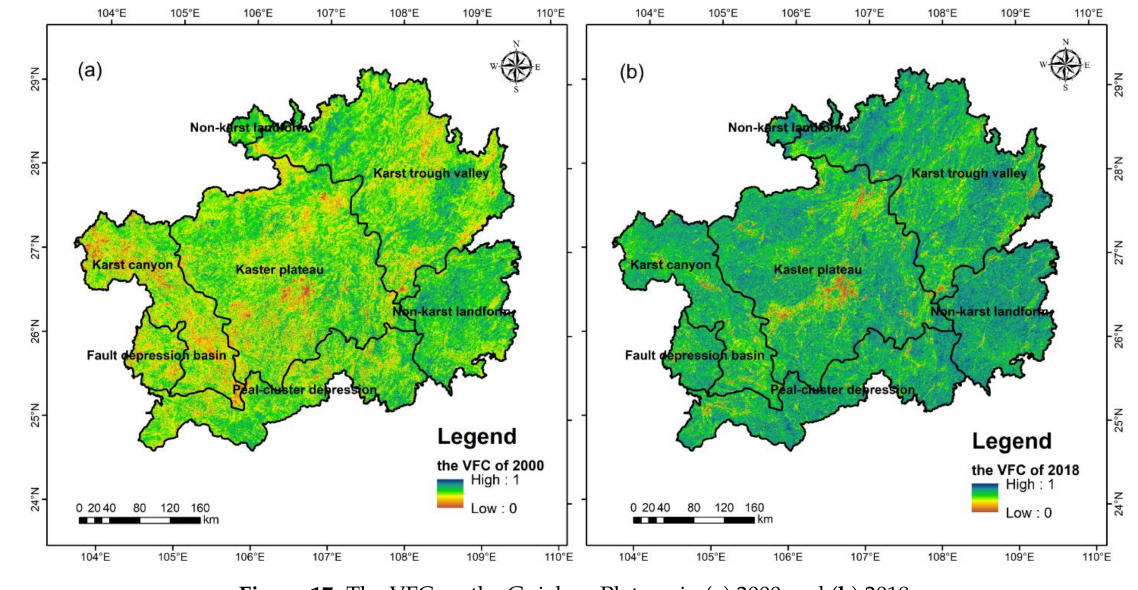
Figure 17. The VFC on the Guizhou Plateau in ( a ) 2000 and ( b ) 2018. Table 6. The VFC associated with di ff erent landform regions and di ff erent ecological engineering projects in 2000 and